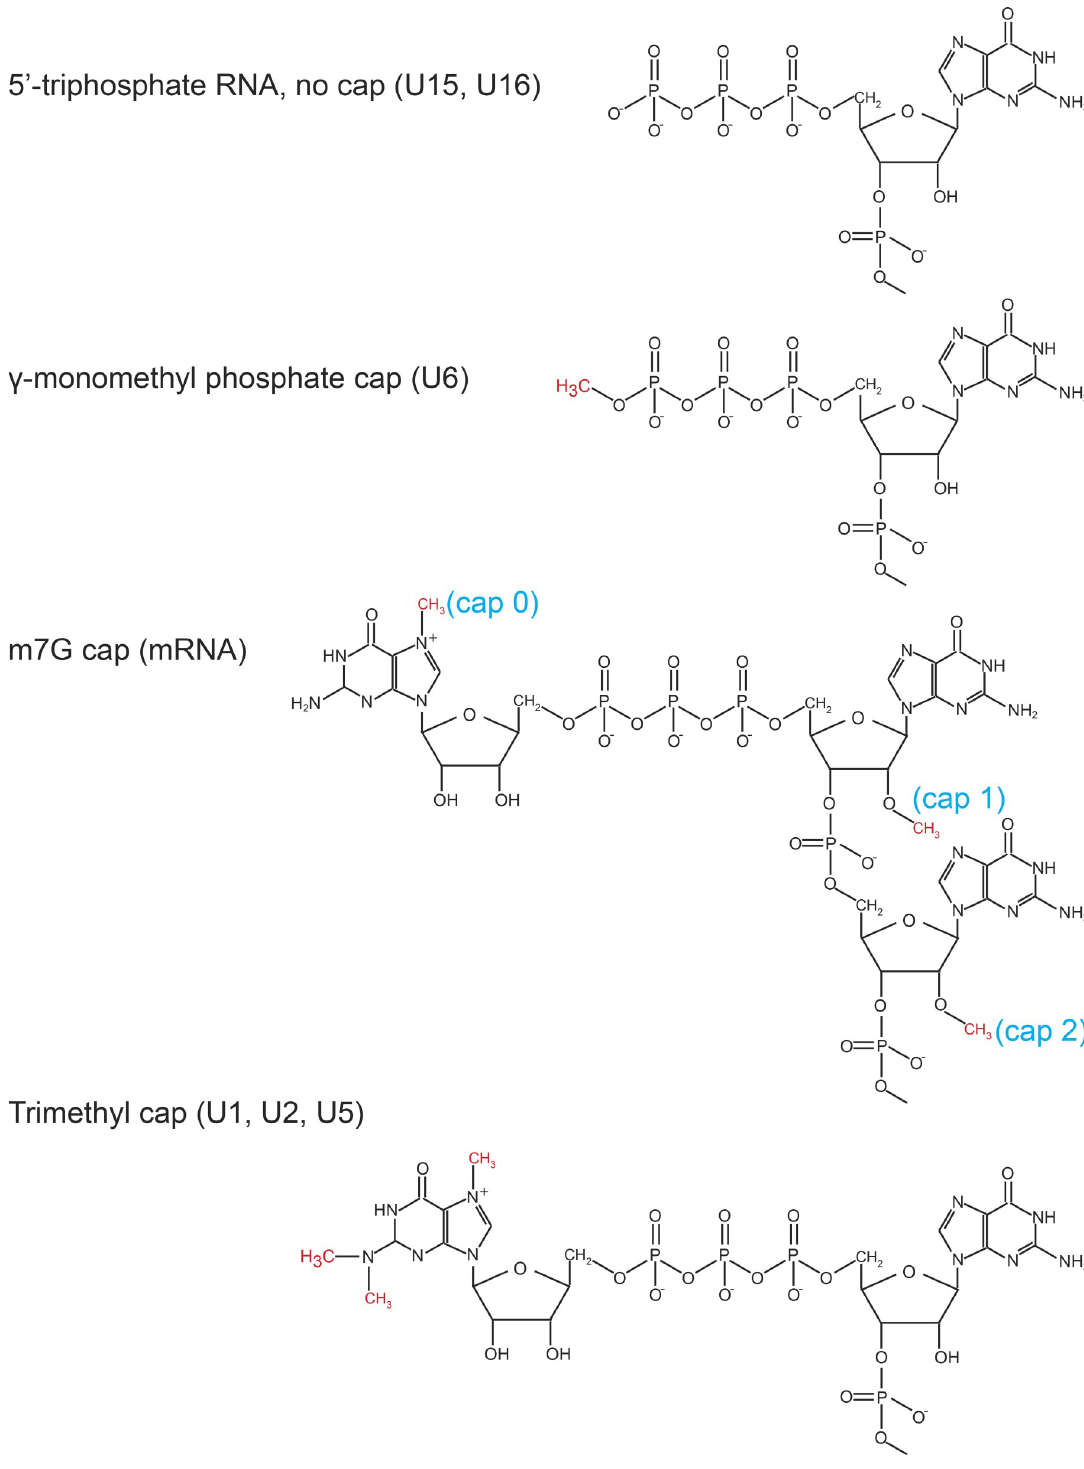
Fig 7. Structures of RNA 5’ caps. Structures of RNAs with 5-triphosphate (no cap), γ -monomethyl phosphate cap, m7G caps (cap 0, cap1, cap2) and trimethyl cap. Methyl groups are shown in red and the various types of caps are labeled in blue. Based on structures described in